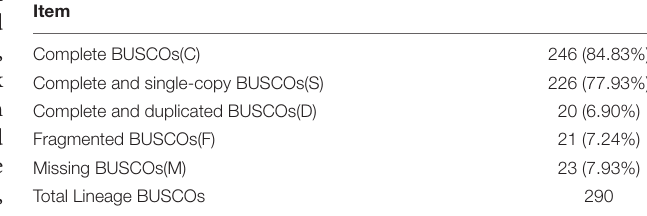
TABLE 3 | BUSCO evaluation